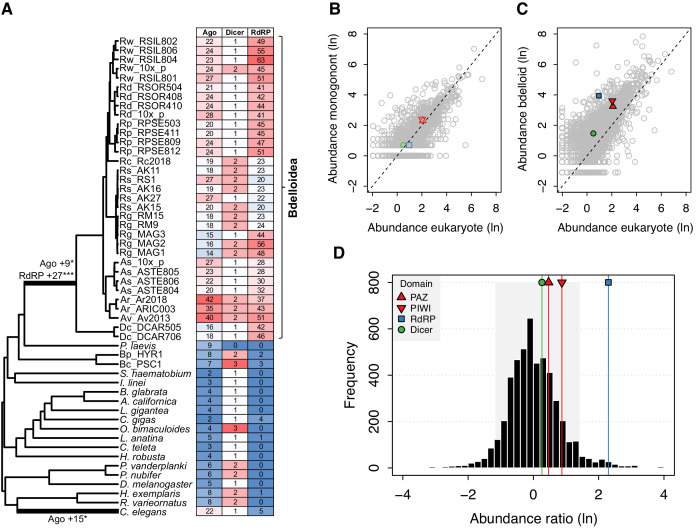
Evidence for significant expansion of Argonaute and RdRP gene families in bdelloids.(A) Evidence for significant expansion of Argonaute (+9 copies; p<0.05) and RdRP (+27 copies; p<0.001) on the stem branch leading to the bdelloid clade. A significant expansion of Argonaute genes (+15 copies; p<0.05) is also found on the branch leading to the nematode C. elegans, corresponding to the nematode WAGO genes. Phylogeny is based on the concatenated alignment of a subset of core eukaryotic (BUSCO) proteins for this set of 59 taxa (Figure 2—source datas 3 and 4). Numbers of Ago, Dicer, and RdRP proteins (based on HMM hits of key domains to predicted proteomes) are shown in the table, shaded by their relative abundance. The relatively lower numbers seen for R. socialis and some R. magnacalcarata individuals is probably an artefact of assembly ‘collapse’ due to low heterozygosity in these genomes. (B) Comparative protein-domain abundance plot. Each point represents a Pfam domain ID, with (loge) average abundance (i.e. count) in the reference eukaryote set shown on the X-axis and (loge) abundance in the monogonont B. plicatilis on the Y-axis. The positions of the PAZ and PIWI (key domains of Argonaute; red up/down triangles), RdRP (blue square), and Dicer (green circle) domains are highlighted. Dashed line indicates the 1-to-1 relationship. (C) Equivalent plot for bdelloids, where the Y-axis shows the (loge) average abundance for the A. steineri, R. sordida, and R. sp. ‘Silwood-1’ 10x haploid assemblies. Note that the average abundance for all Pfam entries is shifted above the 1-to-1 line due to the ancient genome duplication in all bdelloids, such that many genes are found in double copy (i.e. homoeologs) even in a ‘haploid’ representation. (D) Comparative protein-domain abundance plot for bdelloids versus eukaryotes (see Materials and methods). Entries to the right of the mean of the distribution are overrepresented in bdelloids with respect to eukaryotes. The shaded area represents the 5% and 95% quantiles of the distribution, and the scores for the PAZ, PIWI, Dicer, and RdRP domains are indicated (see legend).Figure 8—source data 1.CAFE model fitting birth rate model to gene family evolution of RNAi pathways.Figure 8—source data 2.Pfam count data.